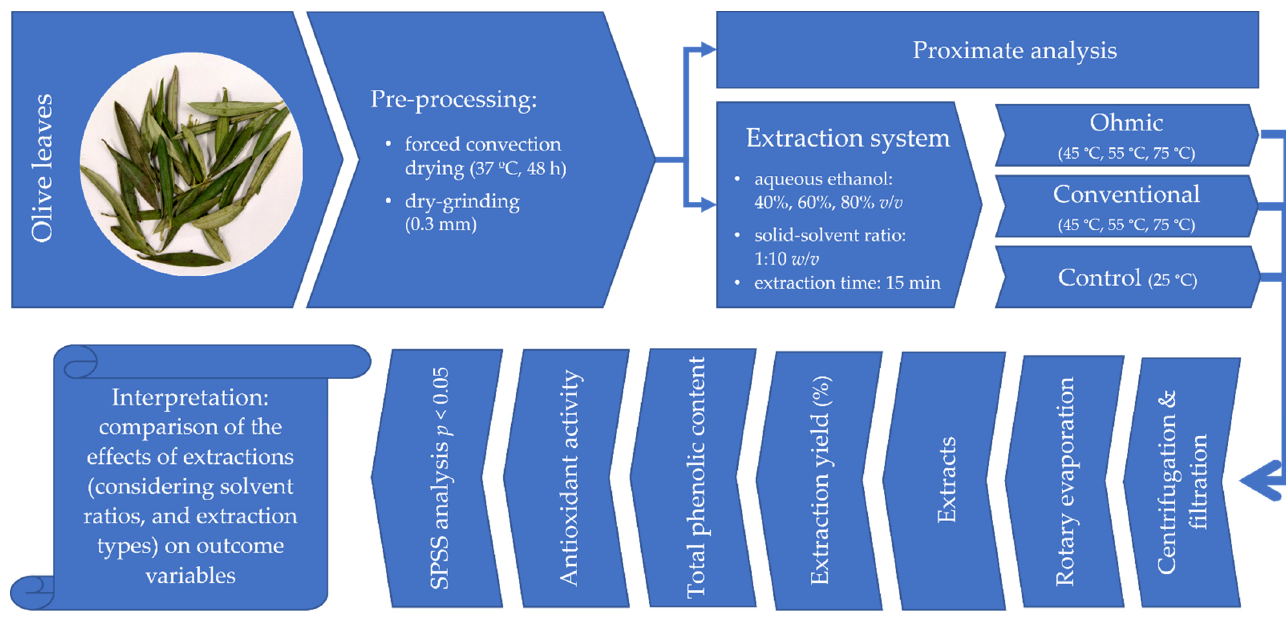
Figure 1. Summary of the experimental design.